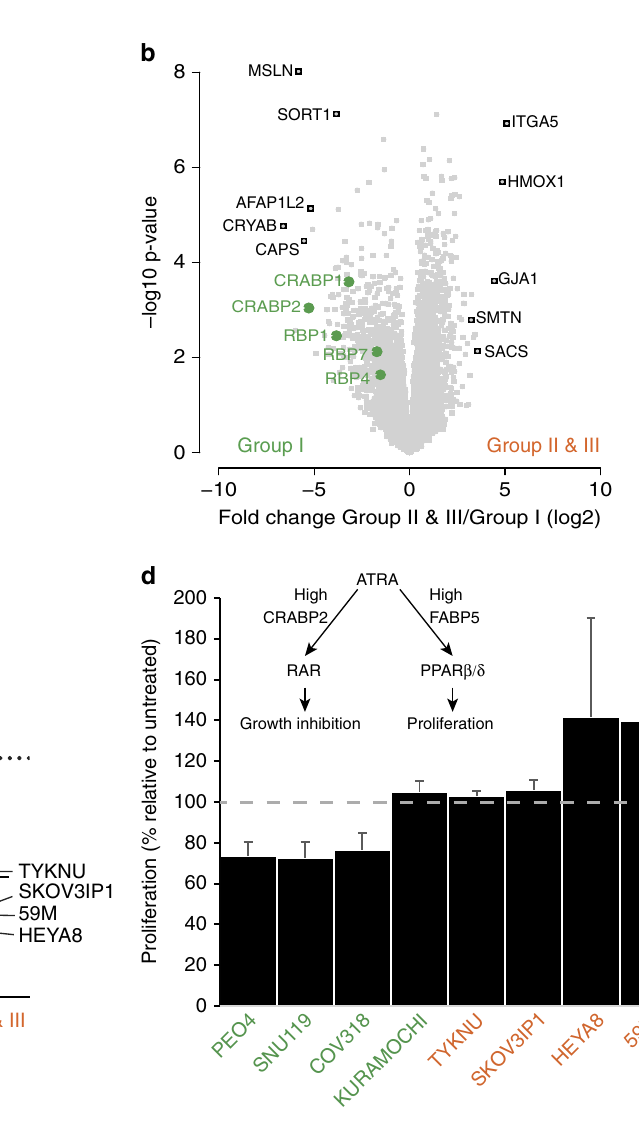
Figure 6 | Proteomic profiles predict functional cell line properties. ( a ) Pairwise comparison of enriched annotations for group I (cluster 1) and groups II and III (cluster 2) cell lines. Pathway enrichment analysis was calculated on the basis of the protein expression fold change between group I and groups II and III cell lines. Green and orange bars denote the strongest enriched pathways (Benjamini–Hochberg FDR o 0.02) in group I and groups II and III cell lines, respectively. Annotation enrichment position score, between (cid:2) 1 and 1, indicates the centre of the protein distribution for each significant category, relative to the overall distribution of values. Dendrogram shows sample clustering, based on the 67-protein signature. ( b ) Volcano plot of the pairwise comparison between group I and groups II and III cell line proteomes. Expression fold changes ( t -test difference, log2) were calculated and plotted against the t -test P value ( (cid:2) log10). Vitamin A pathway-associated proteins are highlighted in green. Their position on the left side of the plot indicates their higher expression in group I cell lines ( P ¼ 0.003). Strongest outlier proteins for both groups are marked in black. ( c ) Relative protein levels of the retinoic acid transporter proteins CRABP2 and FABP5 were compared between FTECs, HGSOC, group I cell lines and groups II and III cell lines. The CRABP2/FABP5 ratios are shown. Groups II and III cell lines show significantly lower levels of CRABP2 expression relative to FABP5 (two-sided t -test, P value o 0.001). The cell lines used in subsequent proliferation experiments (d) are indicated. ( d ) ATRA treatment induces growth arrest or differentiation in group I cell lines. Group I (green) and groups II and III (orange) cell lines were treated with 7 m M ATRA daily for 7 days. On day 8, MTTassays were performed. Results are plotted as the proliferation rate of ATRA-treated cells relative to that of untreated cells. Values o 100% indicate growth arrest; values 4 100% indicate growth promotion. Error bars represent standard errors for two to four replicates per cell line. A simplistic model of the ATRA pathway is shown. ATRA, all- trans retinoic acid; PPAR, peroxisome proliferator-activated receptor; RAR, retinoic acid